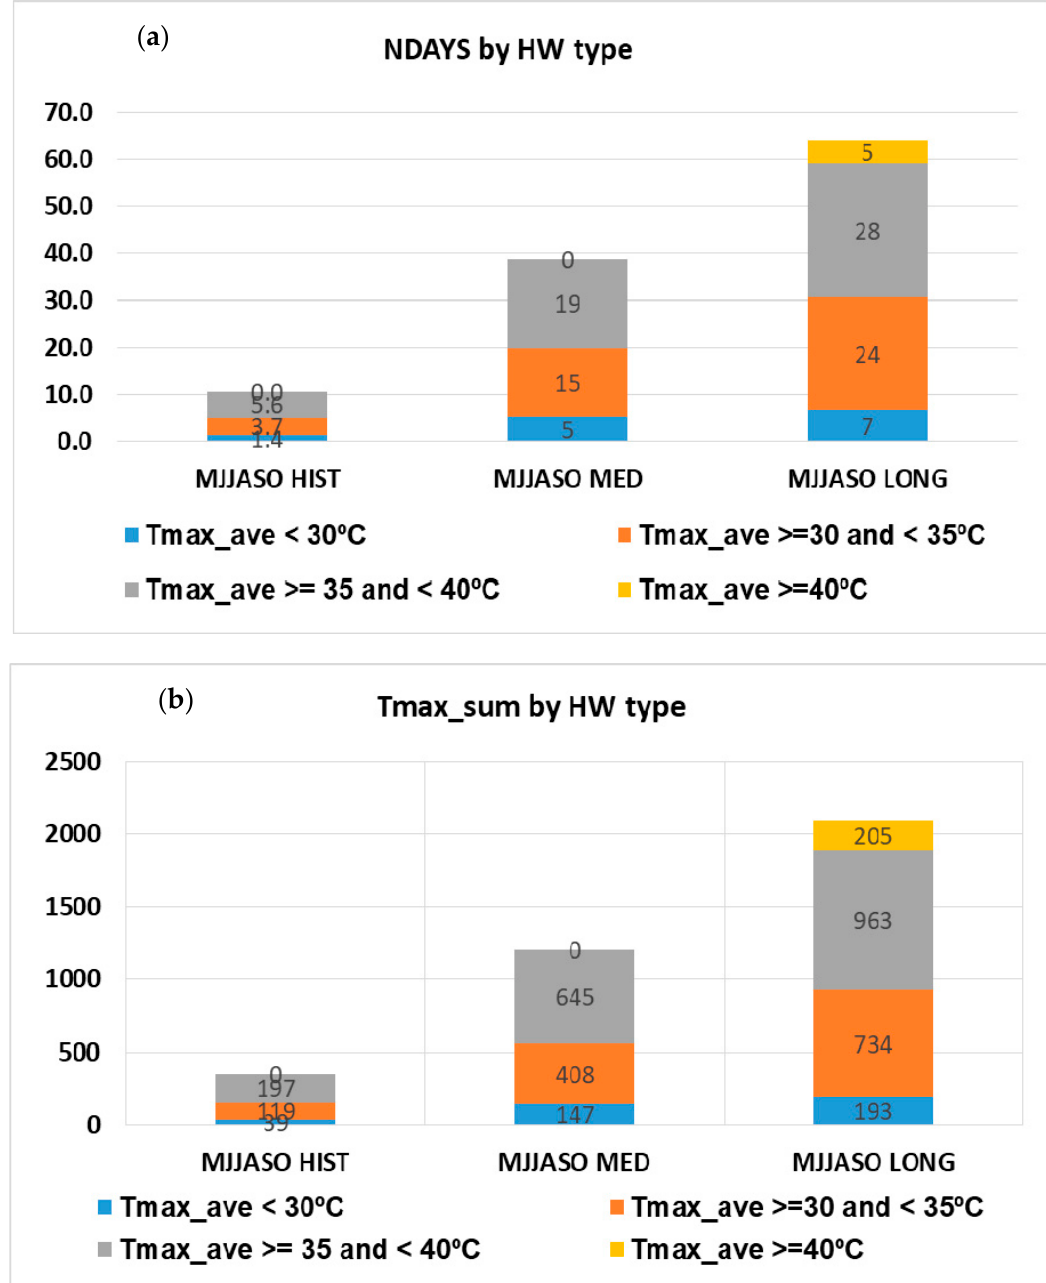
Figure 14. ( a ) NDAYS and (b) Tmax_sum by HW type for HIST, MED, and LONG.